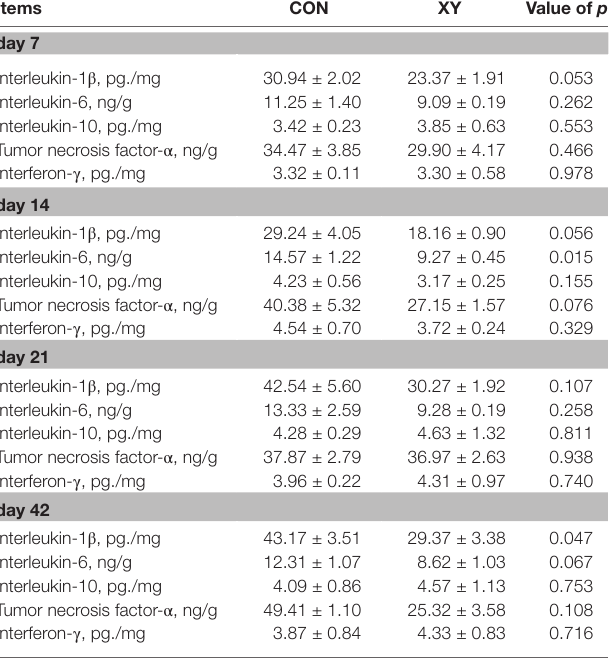
TABLE 7 | Effects of AT-xynA on relative mRNA expression of ileal tight junction genes in broilers. 1